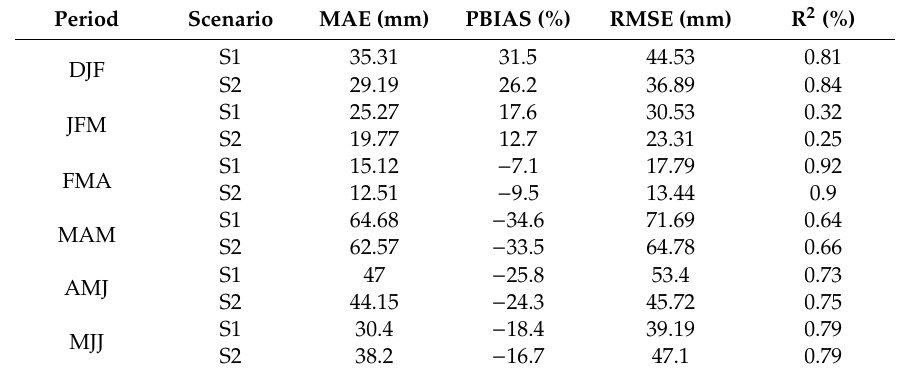
Table 6. Statistical and e ffi ciency indicators for the evaluation of prognostic performance in R2. Period